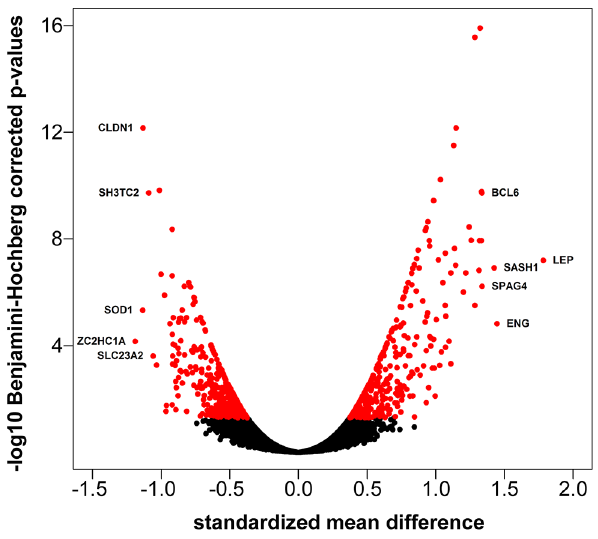
Fig 1. Volcano plot of DEGs. Volcano plot showing the standardized mean difference and the adjusted p- value for the 8,612 genes included on all platforms. The red dots represent genes differentially expressed (adjusted P < 0.05) in the preeclamptic versus normotensive placenta. The symbol-marked dots indicate the five genes with the largest negative or positive standardized mean